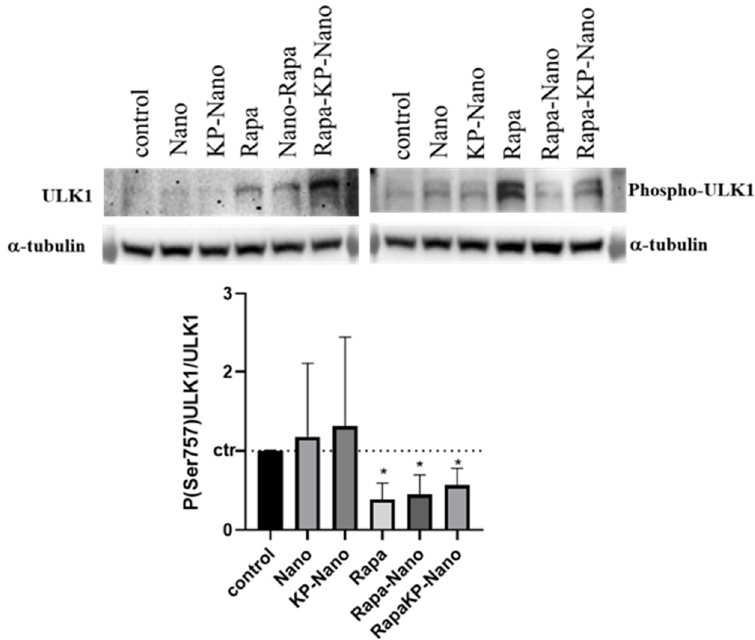
Figure 6. Evaluation of Nano-Rapa activity. Upper panel: Representative image of Western blots for ULK1, Phospo-ULK in Ser 757 and α -tubulin. Protein extracted from cells untreated or treated with the different compound for 24h. Bottom panel: Densitometric analyses of the biological replicates. The graphs show the ratio between the optical densities (ODs) of P(Ser757)ULK1 and ULK1, both previously normalized for the ODs of the respective α -tubulin. The values are represented vs. untreated cells. * p value < 0.05.